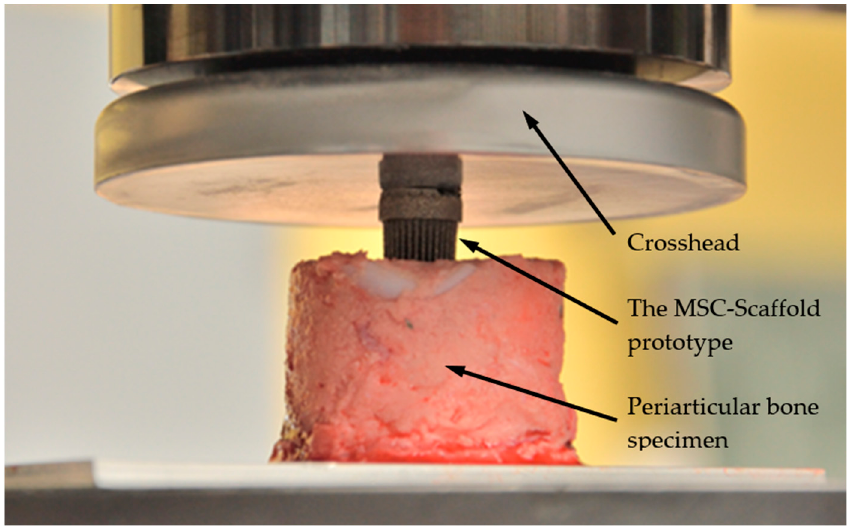
Figure 4. The experimental stand with a bone-implant specimen prepared for the MSC-Scaffold prototype quasi-static embedding tests.